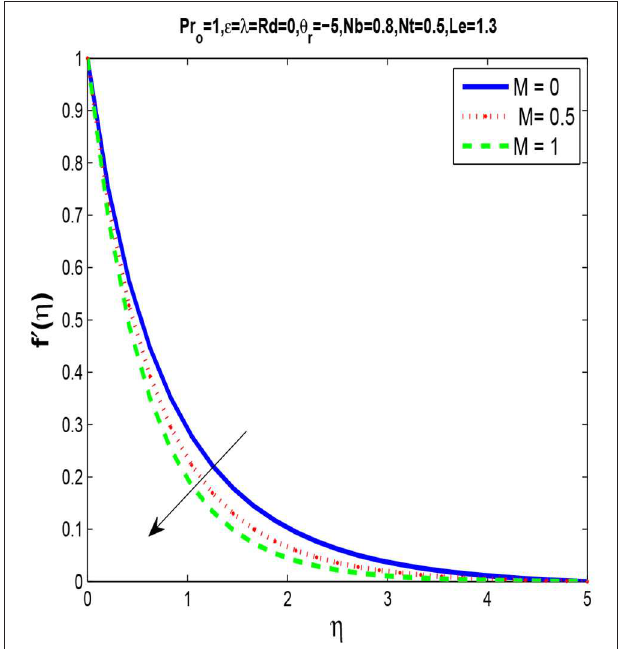
FIGURE 4 | Temperature profile θ ( η ) for different ǫ ( For Case B).